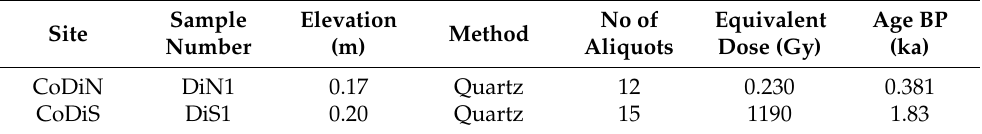
Table 2. Age determination results of the selected Diolkos